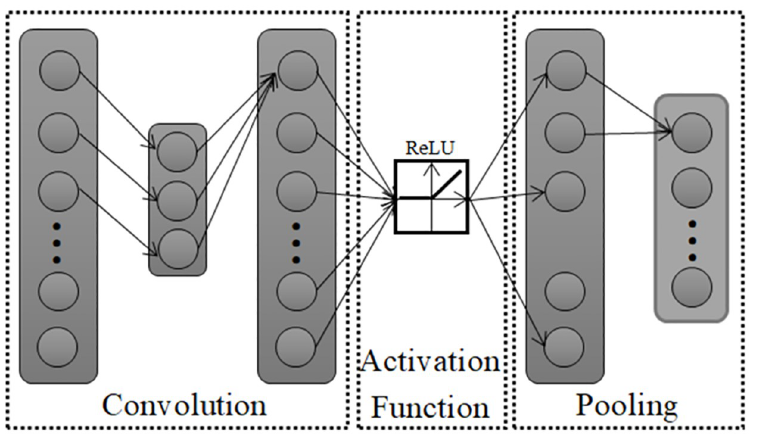
Fig 1. 1D-Convolutional neural network